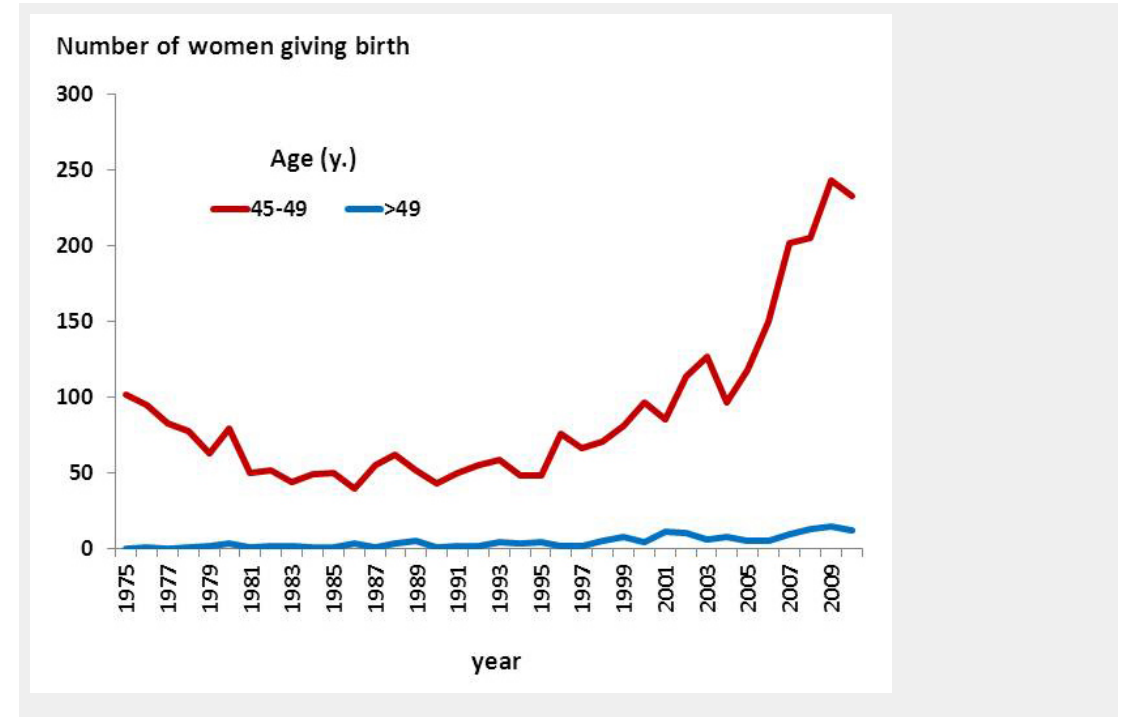
Since 1995 the number of women aged 45 years and older giving birth is on the rise (Source: BfS ■■■). This steep increase can only be explained by women receiving oocyte donation in foreign institutions and must be considered as a striking example of reproductive